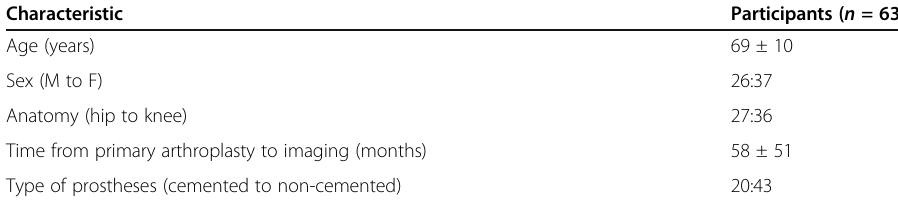
Table 1 Baseline demographic, timing of imaging, and type of prostheses in participants